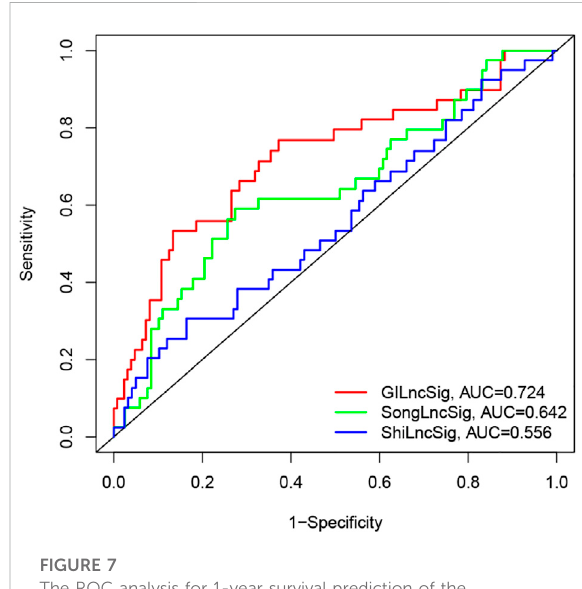
FIGURE 7 The ROC analysis for 1-year survival prediction of the GInLncSig and the other two existing signatures (SongLncSig, ShiLncSig),